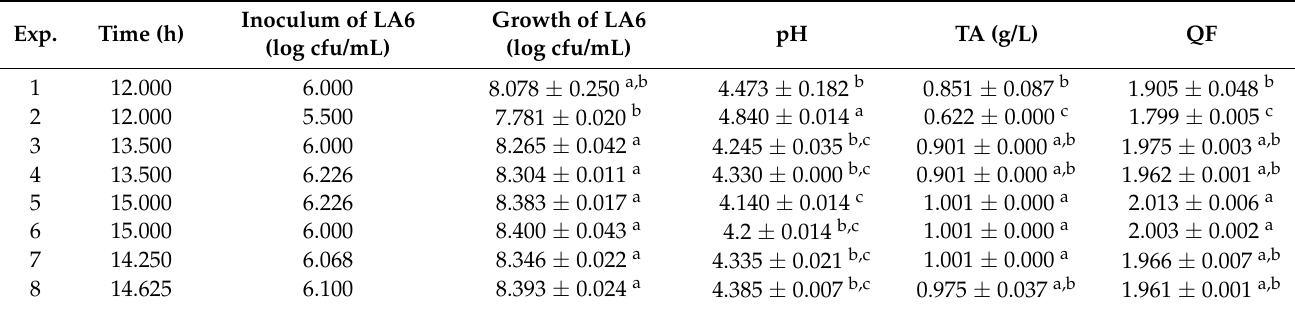
Table 4. Results of the Nelder–Mead simplex process and the Quality